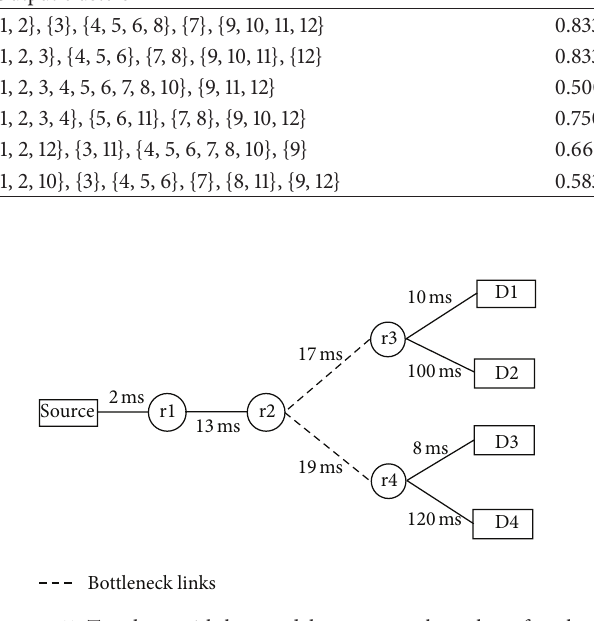
Figure 11: Topology with longer delays at some branches after the